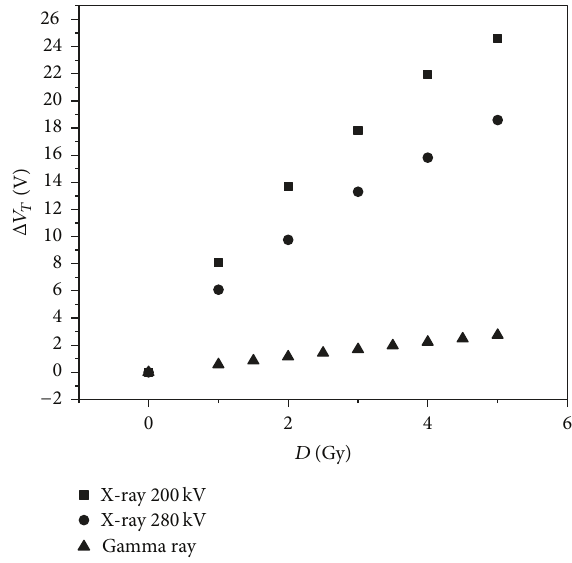
Figure 6: Δ𝑉 𝑇 during 200 kV and 280 kV X-ray as well as gamma- ray irradiation with zero gate bias.